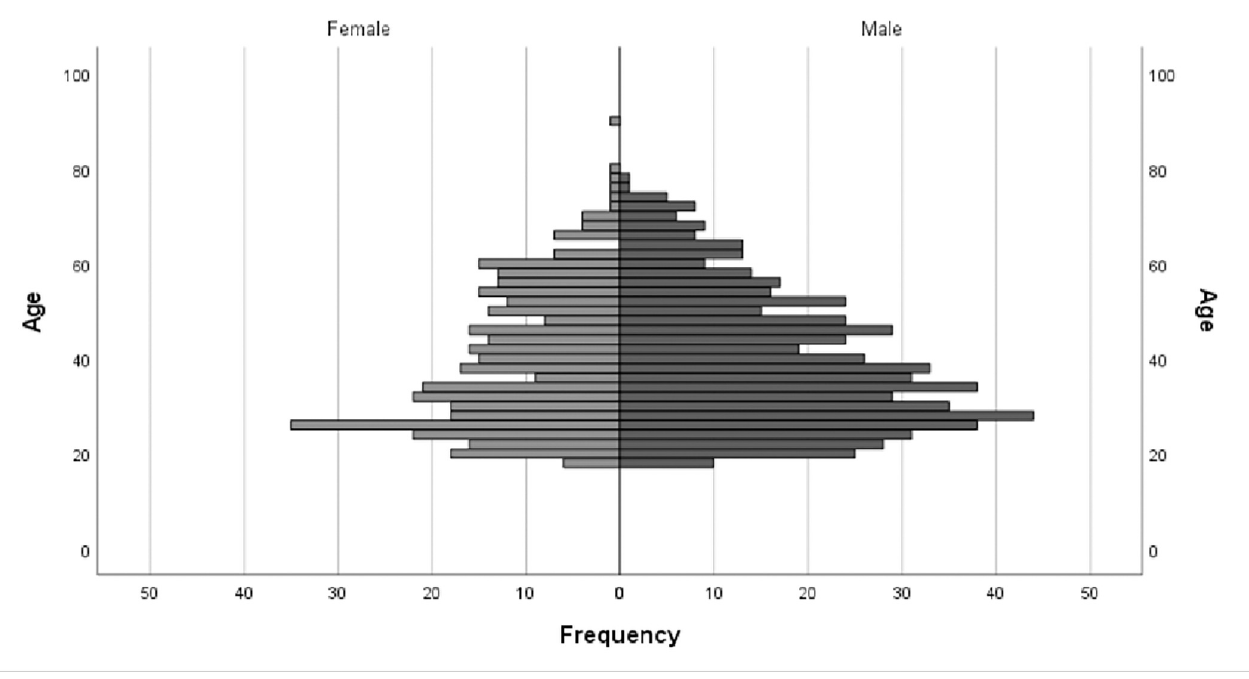
Fig 2. Pyramid histogram showing age and sex